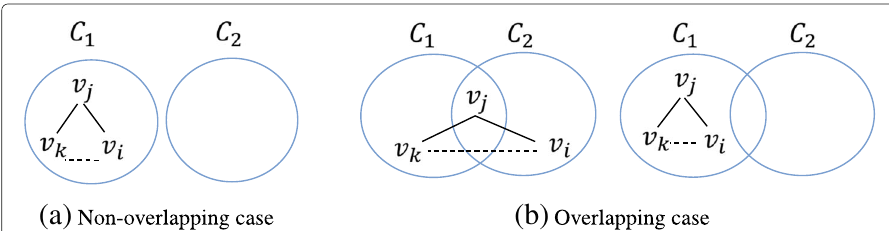
Fig. 1 In the non-overlapping case ( a ), the transitive property allows us to infer a third must-link constraint from two existing must-link constraints. However, this does not automatically apply in the overlapping